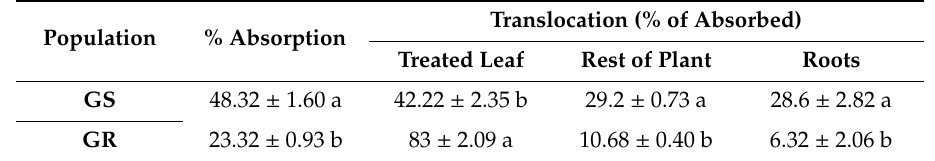
Table 3. Radiolabel translocation from the treated leaves in the resistant (GR) and susceptible (GS) populations of C. distichophylla 96 hours after treatment with 14 C-glyphosate. Translocation (% of Absorbed) Population % Absorption Treated Leaf